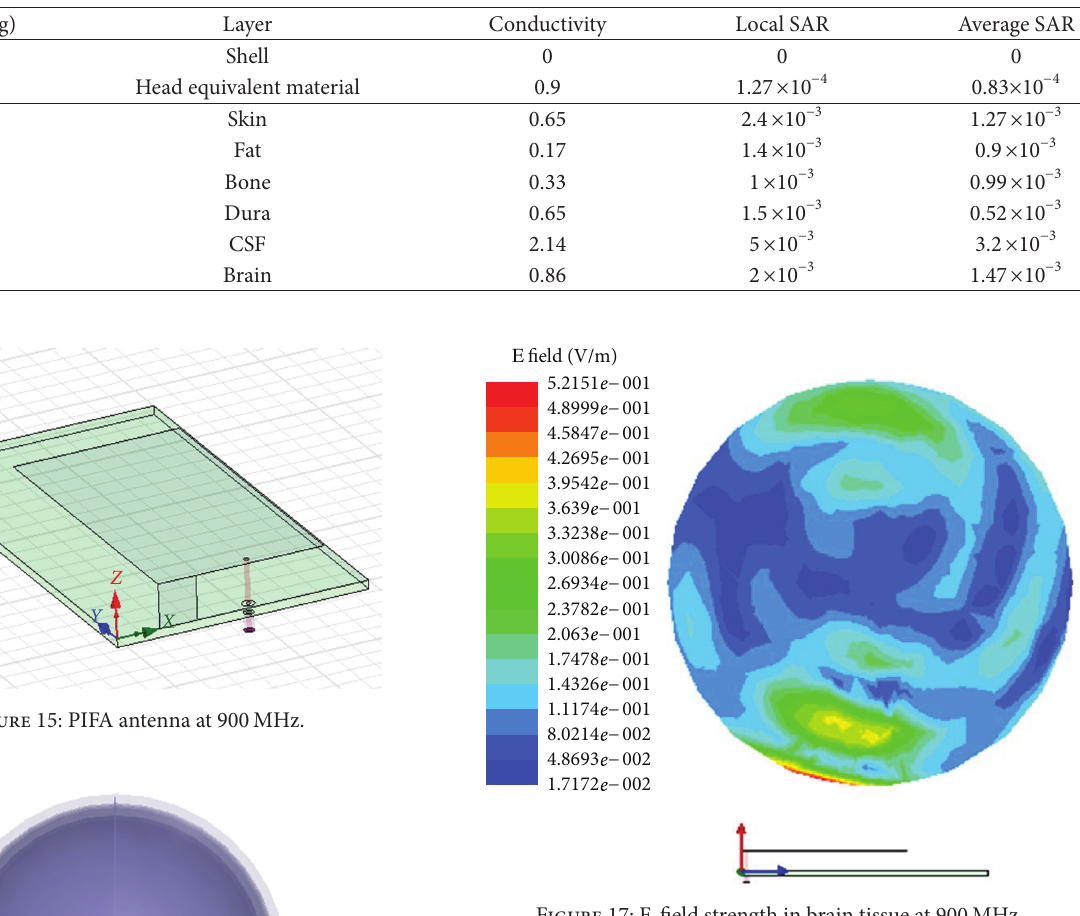
F 17: �-�eld strength in brain tissue at 900MHz.